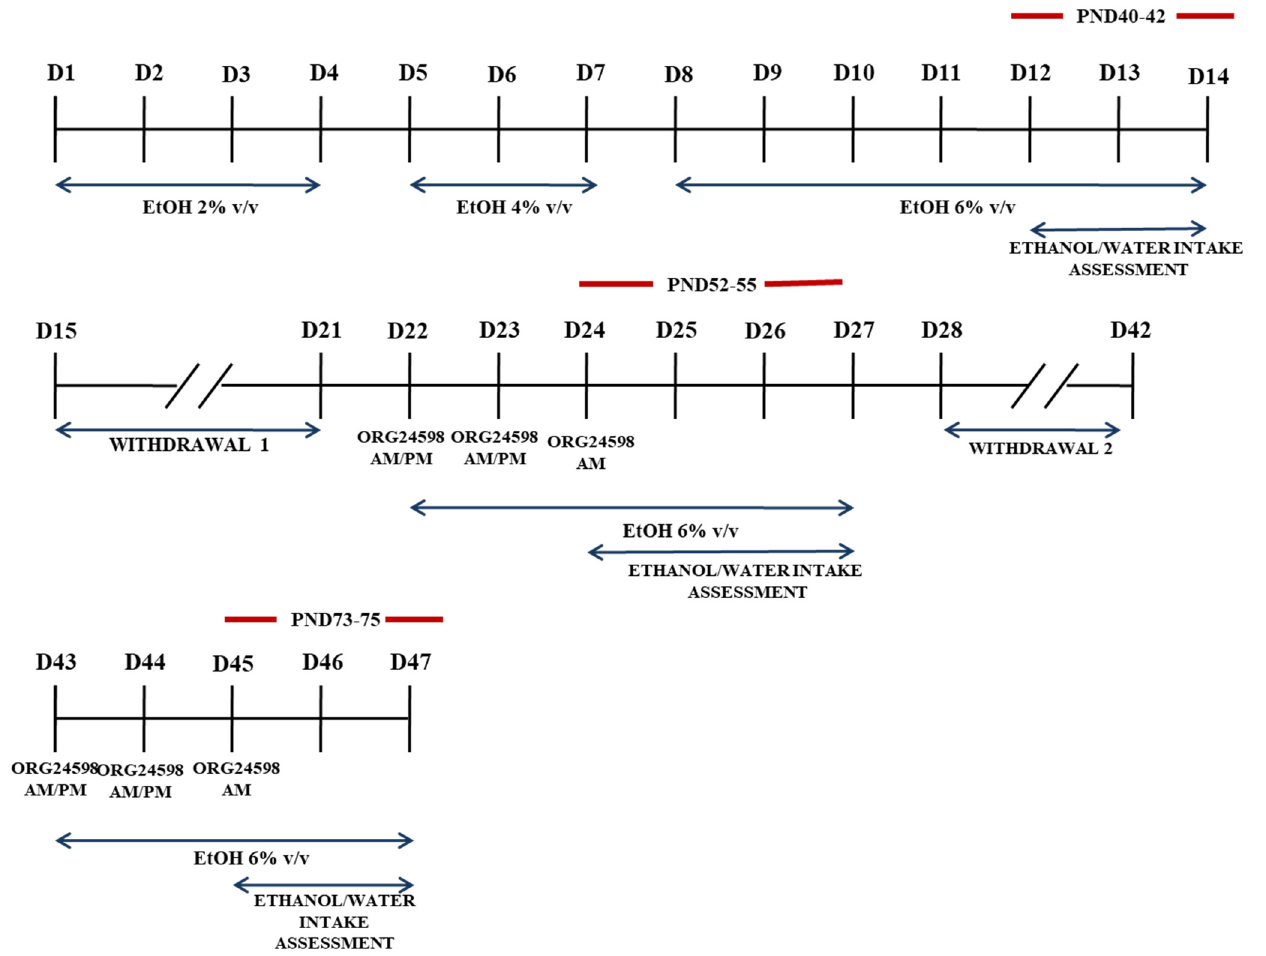
Figure 4. Experimental outline used for voluntary consumption of ethanol in adolescent adult Wistar rats subjected to MS during PND1-21 for 180 min. The timeline shows the sequence and duration of the experimental protocol. EtOH—ethanol; D—day of experiment; AM—morning;